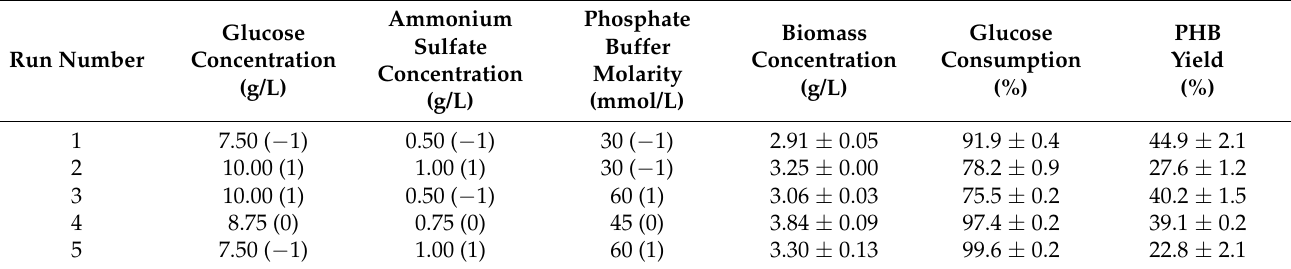
Table 2. Experimental matrix with actual and coded level of independent variables and measured values of biomass concentration (g/L), glucose consumption and PHB yield